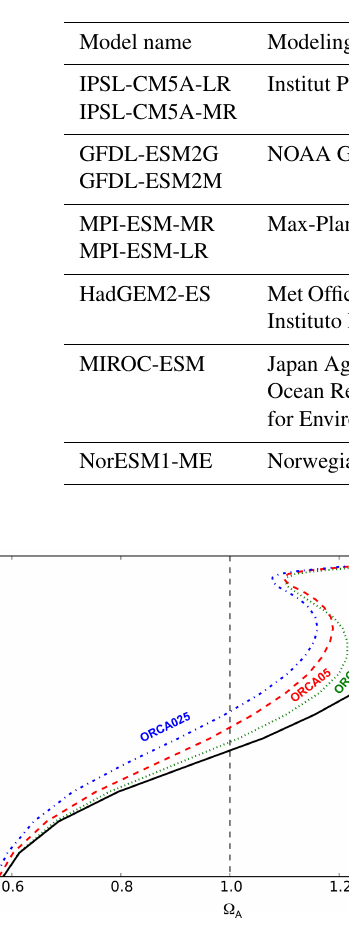
Figure 10. Profiles of (cid:127) A for ORCA05 in 1960 (black solid) as well as ORCA2 (green dots), ORCA05 (red dashes), and ORCA025 (blue dot–dash) in 2012. The vertical black dashed line indicates the chemical threshold where (cid:127) A = 1. The point where that vertical line intersects the other curves indicates the depth of the